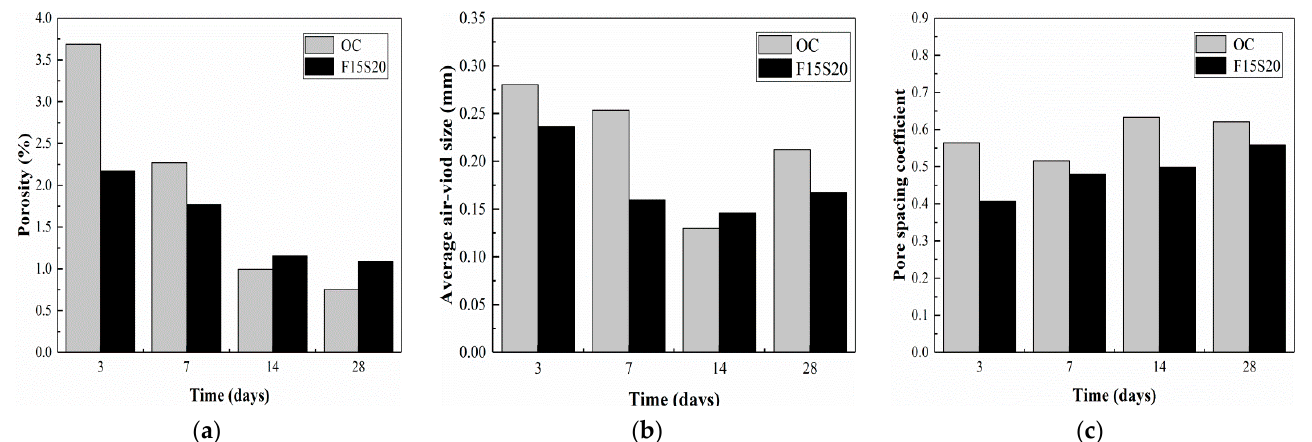
Figure 13. Pore structure parameters of concrete at different ages: ( a ) porosity of concrete; ( b ) average air-void size of concrete; ( c ) pore spacing coefficients of concrete.